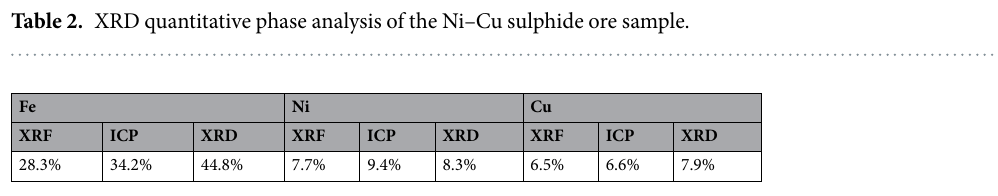
Table 3. Content of the major metallic elements (Fe, Ni, Cu) in Ni–Cu sulphide ore sample, determined by XRF, ICP, and